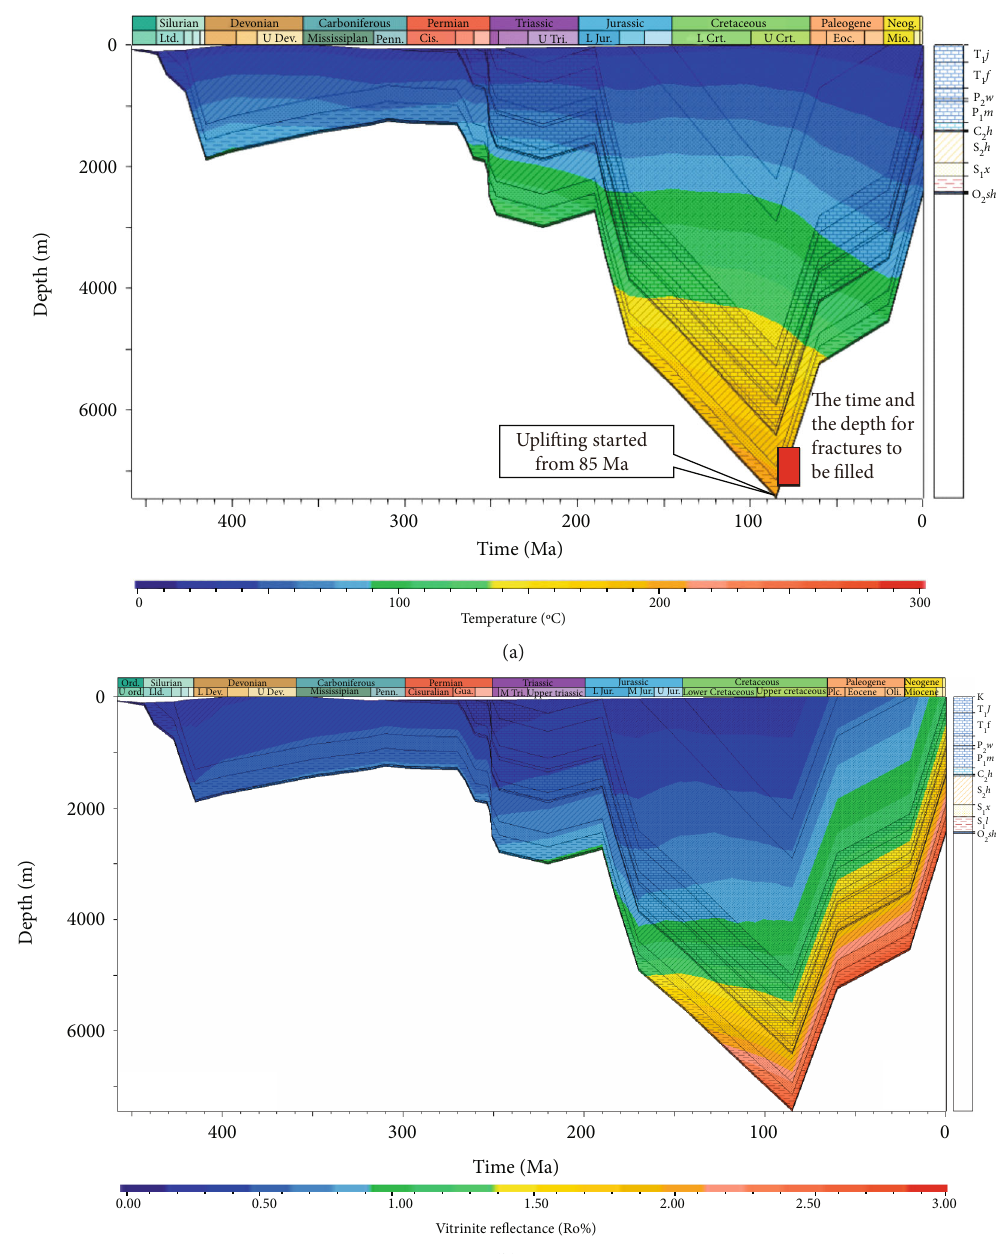
Figure 5: Burial-history reconstruction for JY 1 Well in the Sichuan Basin: (a) Superimposed history of temperature changes; (b) Superimposed history of thermal maturity R . The well ’ s location is in Figure 1. The model was built through the PetroMod software. o Compaction and uplift were based on thermal maturity calibrated by the thermal maturity data of Wufeng Formation-Longmaxi Formation shales and measured borehole temperatures. JY 1 Well. K: Cretaceous; T j : Jialingjiang Formation in the Triassic; T d : Daye 1 1 Formation in the Triassic; T f : Feixianguan Formation in the Triassic; P w : Wujiaping Formation in the Permian; P m : Maokou 1 2 1 q : Qixia Formation in the Permian; P l : Liangshan Formation in the Permian; C h : Huanglong Formation in Formation in the Permian; P 1 1 2 the Carboniferous; S h : Hanjiadian Formation in the Silurian; S x : Xiaoheba Formation in the Silurian; S l : Longmaxi Formation in the 2 1 1 Silurian; O : Middle Ordovician (Baota Formation-Shizipu Formation); O sh : Shizipu Formation in the 2 2